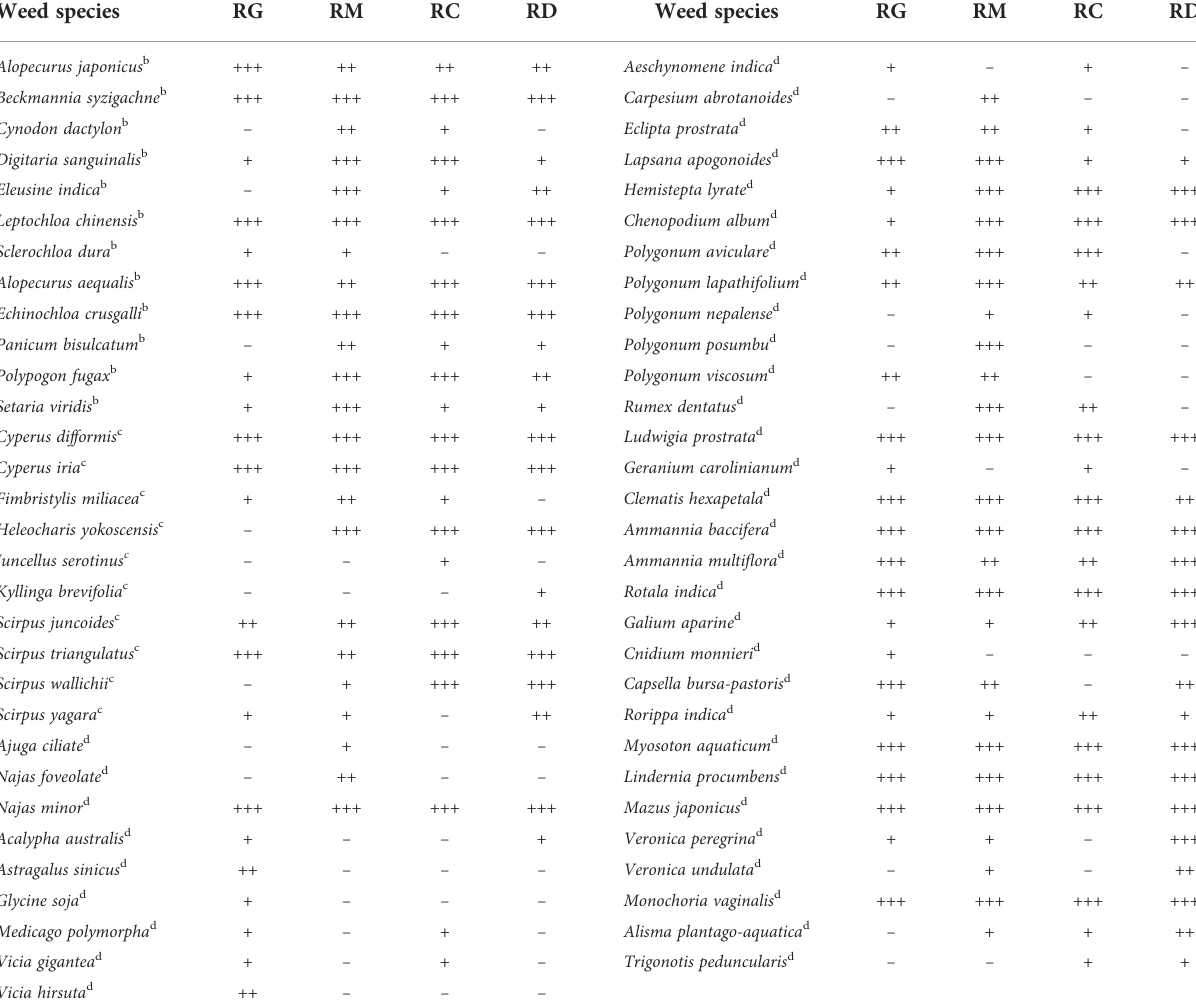
TABLE 2 Weed species of the soil seed banks in different organic rice production modes a . Weed